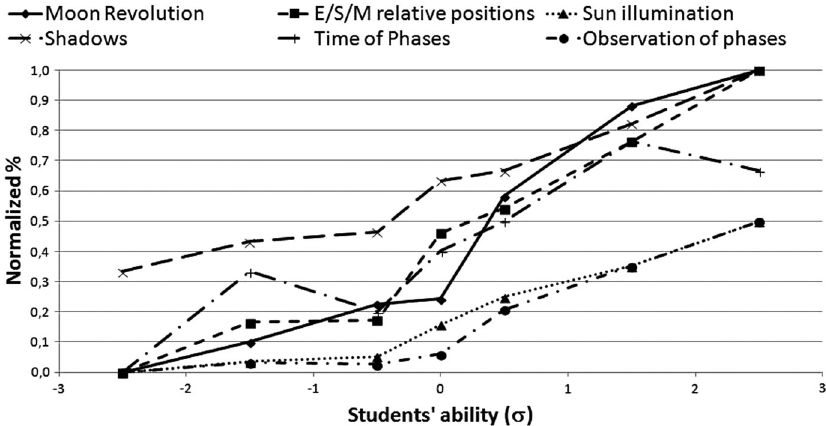
FIG. 5. Item response curves for Moon phases items.